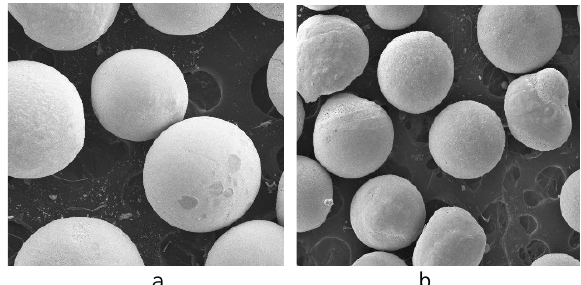
Fig.4. Ti-6Al-4V alloy powder particles sprayed according to the optimal mode (a) and with a deviation from it (current - 170 A), magnification x400.